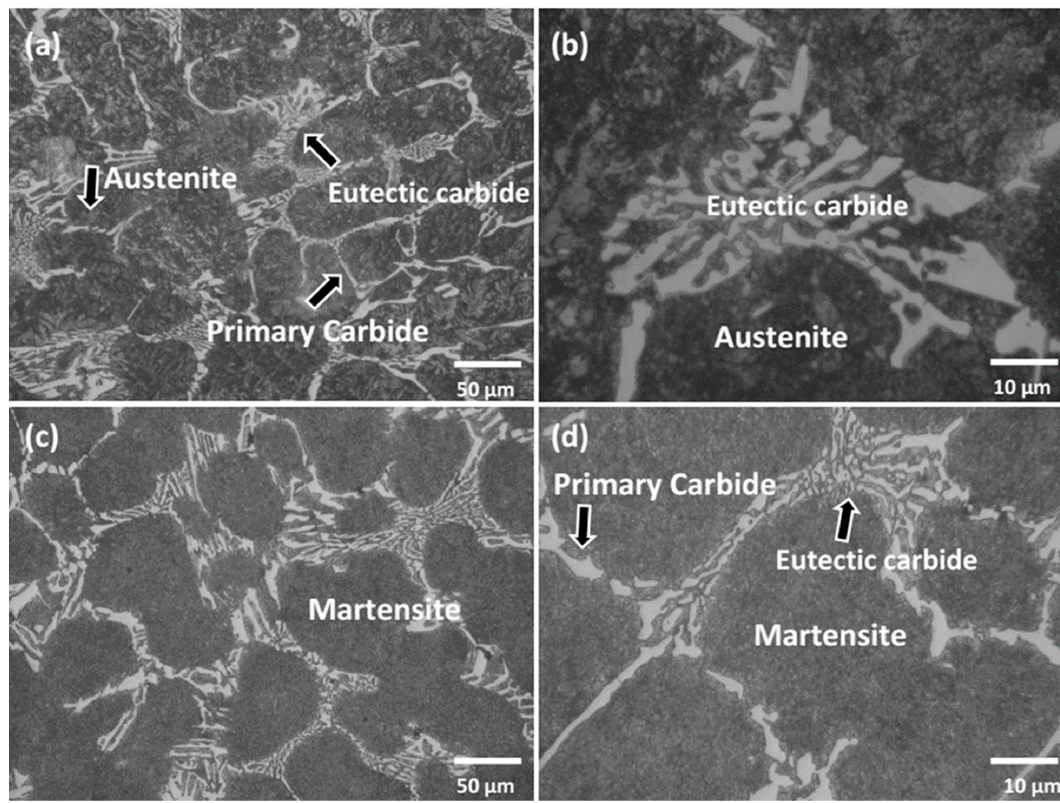
Figure 5. Optical micrographs of ( a ) as-cast sample at 200× and ( b ) at 1000× 1: Eutectic carbides, 2: M 7 C 3 eutectic carbides; ( c ) heat treatment ( HT) sample at 200× and ( d ) at 1000× 1: Eutectic carbides 2: Martensitic matrix.